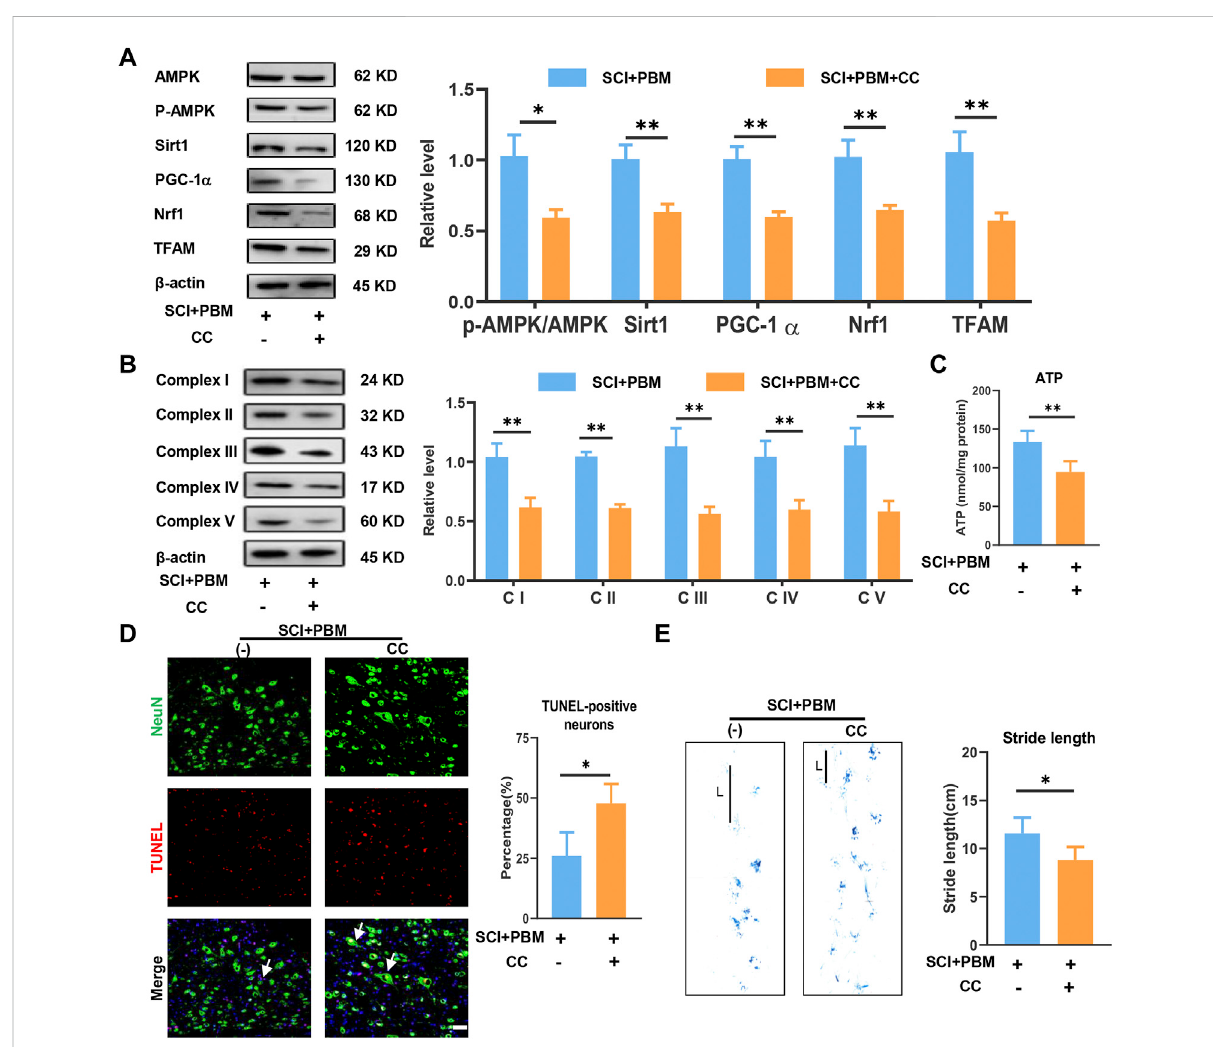
FIGURE 4 Inhibition of AMPK/PGC-1 α /TFAM pathway reverses the effects of PBM in vivo . (A) : Western blot analysis and quanti fi cation of p-AMPK/AMPK, PGC-1 α ,TFAM, Sirt1, and Nrf1expression levels at 14 dpi in each group, n = 3. (B) : Western blot analysis and quanti fi cation of the expression levels of Complex I – V at14 dpiineachgroup, n =3. (C) :ResultofATPlevels at14 dpiineachgroup, n =4. (D) :TUNEL (red)andNeuN(green)co-stainedand arrows point to representative cells. The ratio of TUNLE-positive neurons was calculated, Scale bar: 50 µm, n = 4. (E) : Gait analysis and representative gaits at 14 dpi of each group. The stride length was calculated, n =